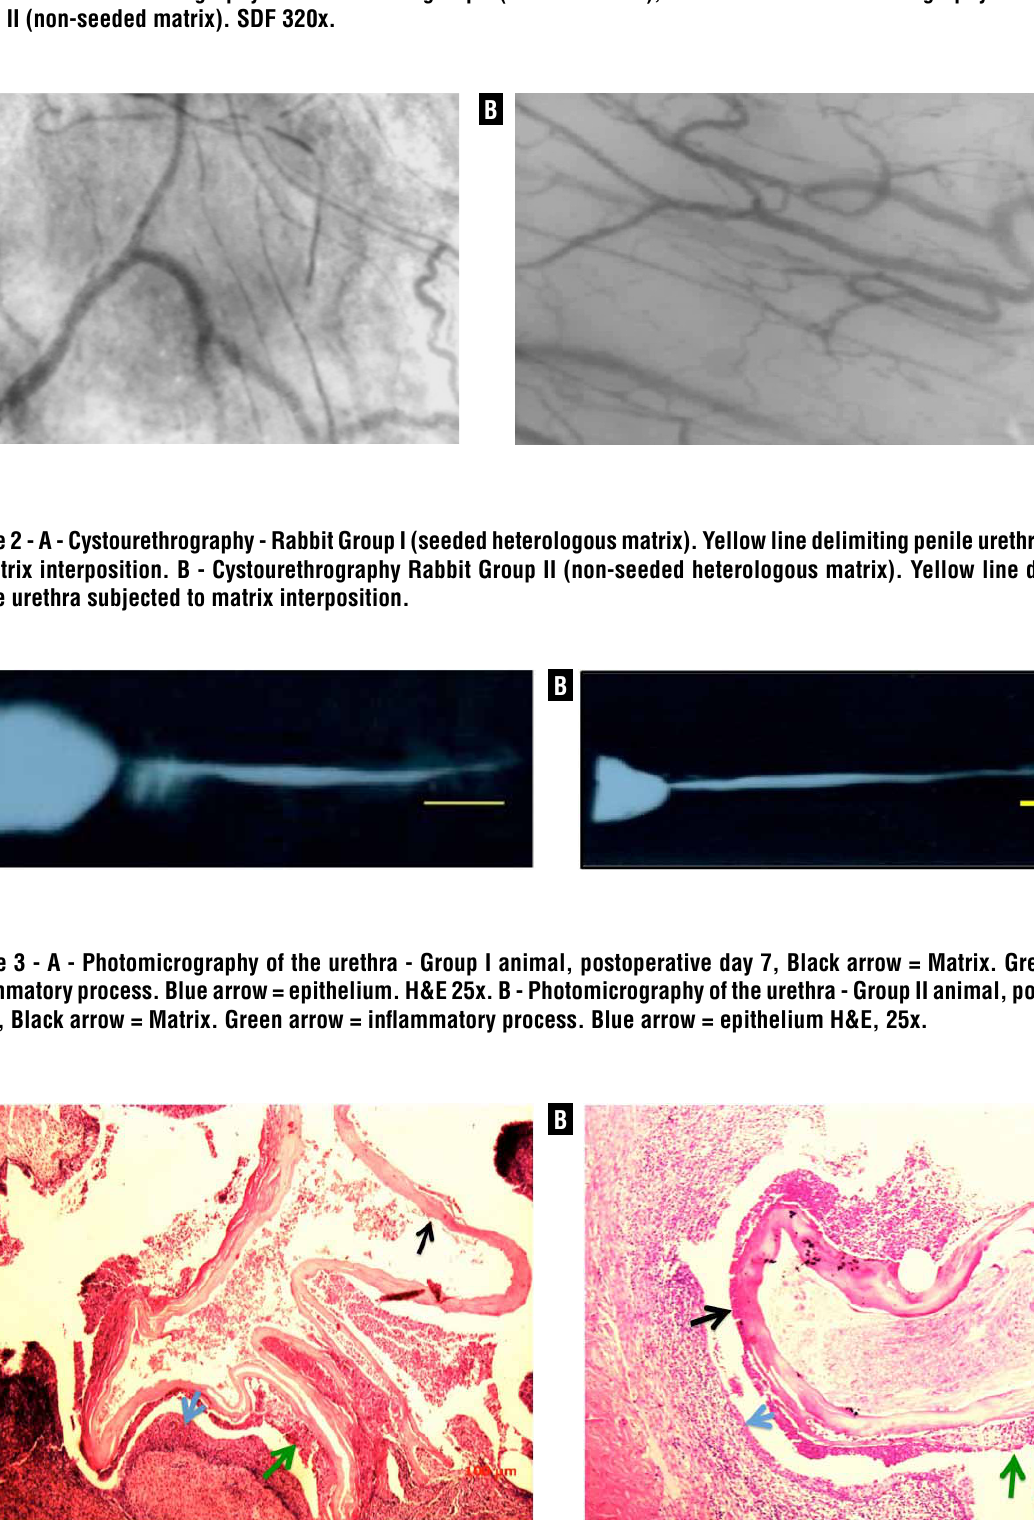
Figure 1 - A - Photomicrography of the urethra - group I (seeded matrix), SDF 320x. B - Photomicrography of the urethra - group II (non-seeded matrix). SDF 320x.